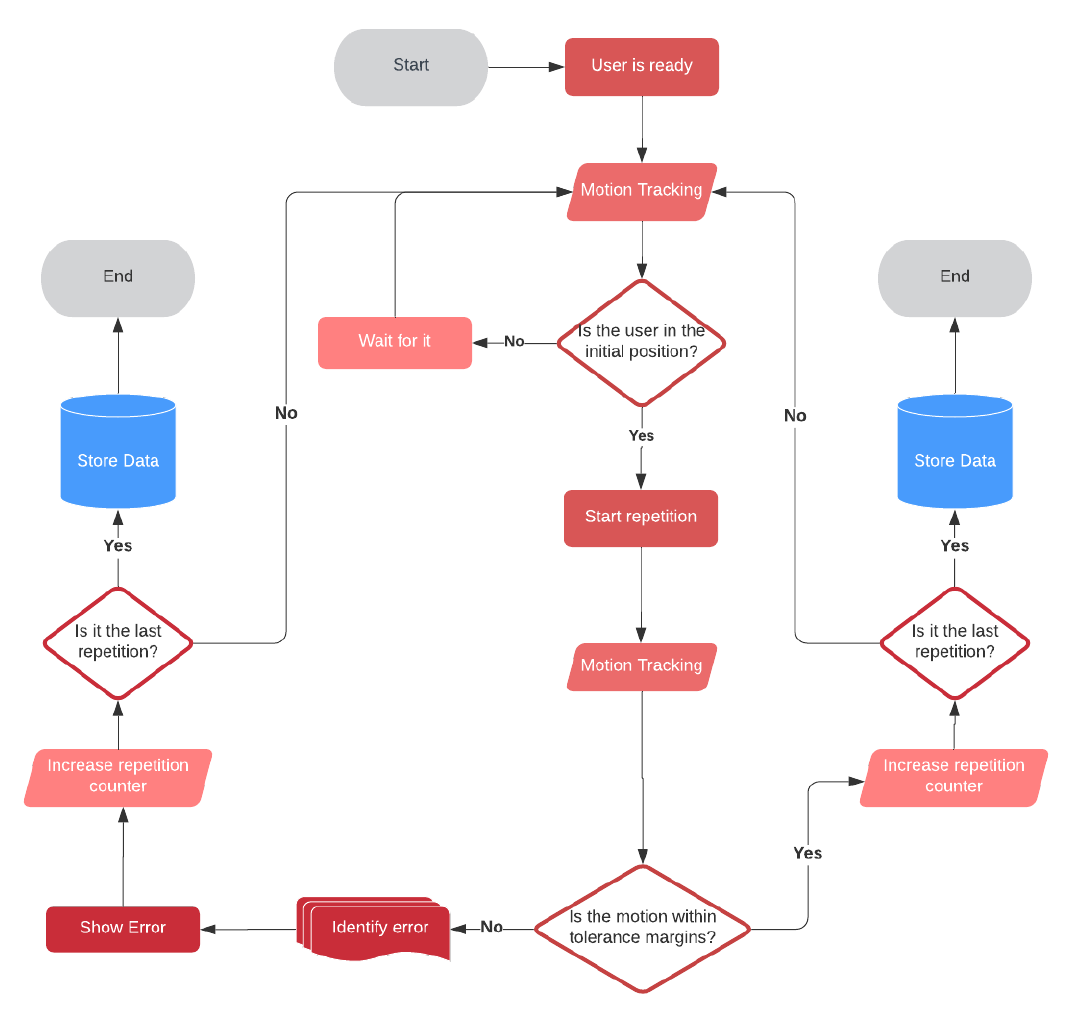
Figure 15. Exercise execution flow diagram.